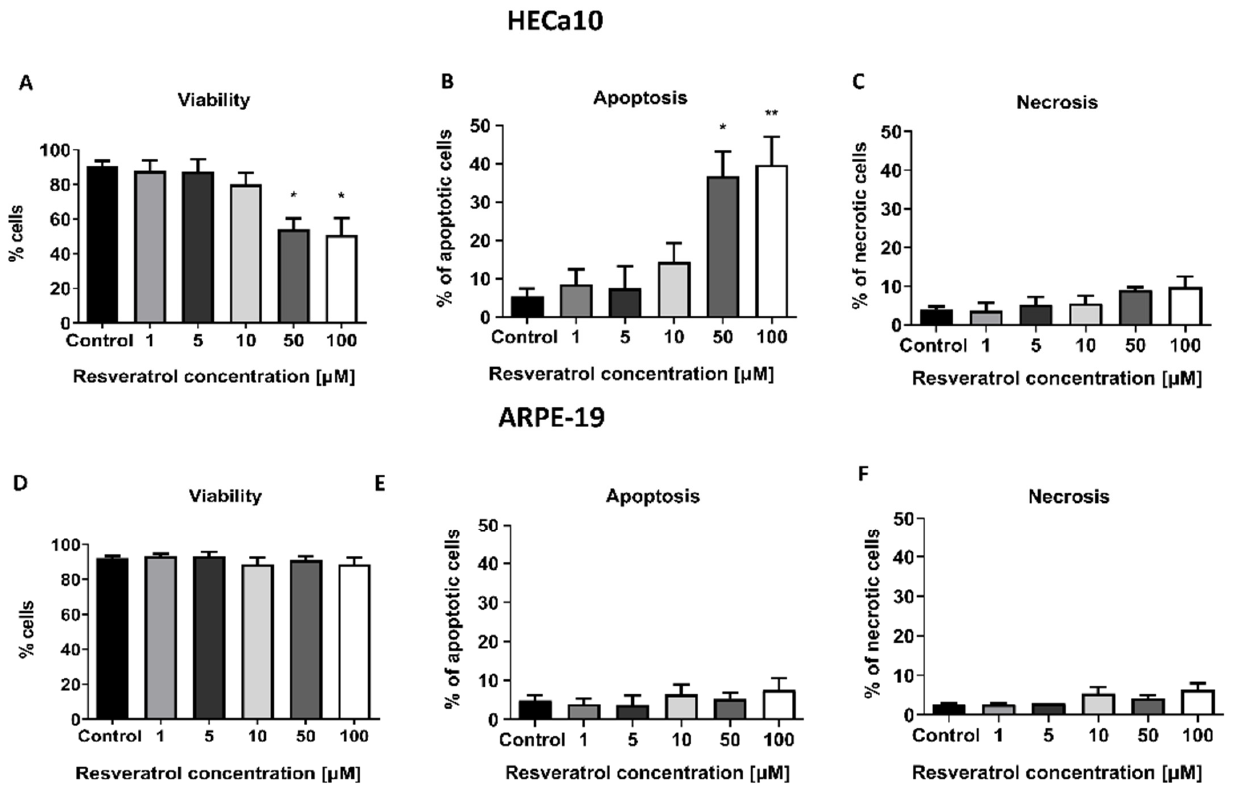
Figure 3. Effect of different RSV concentrations on cell viability, apoptosis, and necrosis on ( A – C ) HECa10 cells; ( D – F ) ARPE-19 cells. Cell were incubated for 24 h with RSV (1, 5, 10, 50, and 100 µM). Control cells were cultured with 0.1% DMSO and without RSV. Cells were stained with Annexin V- FITC/PI solution. Analysis of cell viability, apoptosis, and necrosis was performed by flow cytometry (FACS Calibur, BD). The results are presented as mean ± SD at least three experiments with * p < 0.05, ** p < 0.01 compared to the control.